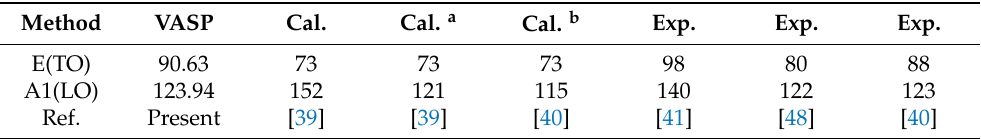
Table 1. Calculated phonon frequencies (in cm − 1 ) from the present and previous studies at the zone center for GeTe, as well as the available Raman experimental data. Method VASP Cal. Cal. a Cal. b Exp. Exp. Exp.